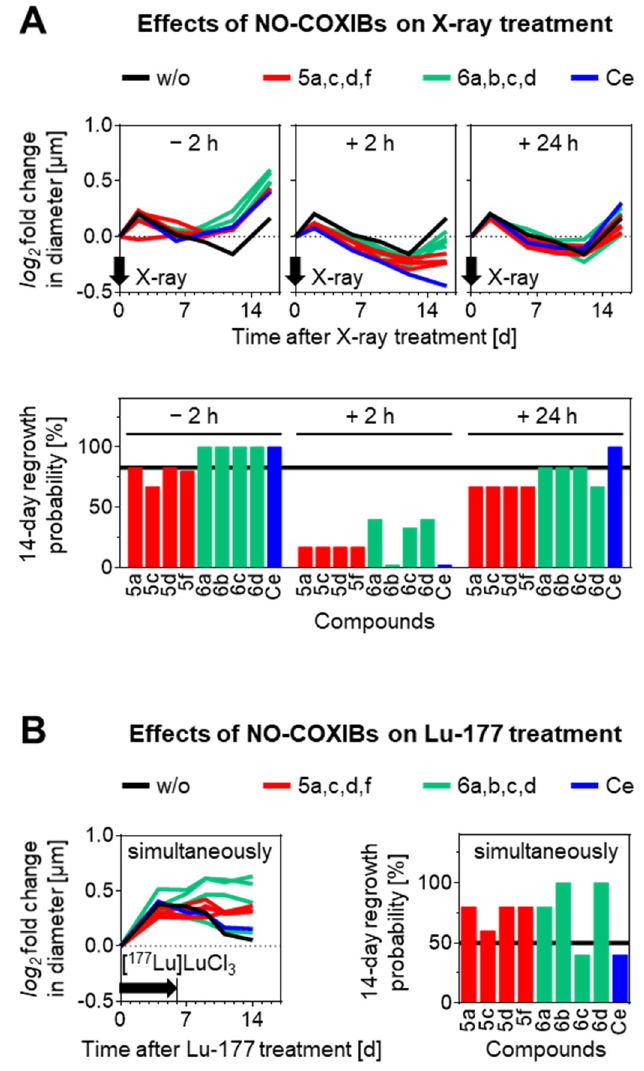
Figure 5. Effects of NO-COXIBs on radiation treatments of MPC-HIF2 α tumor spheroids. ( A ) Growth responses to X-ray treatment with a radiation dose of 15 Gy in combination with 10 µM NO-COXIBs added to the medium at indicated time points before or after irradiation. ( B ) Growth responses to [ 177 Lu]LuCl 3 treatment with an initial activity concentration of 0.25 MBq/mL in combination with NO-COXIBs; log 2 fold changes in diameter indicate the number of diameter doublings compared to treatment start; 14-day regrowth probability indicates the fraction of spheroids able to regrow within 14 days after treatment start; (black arrows) time point or duration of radiation treatment; (w/o) vehicle controls are shown as black lines; (Ce) celecoxib. Altogether, the NO-COXIBs introduced in this study showed the same tendency as celecoxib, exerting both radioprotective and radiosensitizing effects on MPC-HIF2 α sphe- roids when applied shortly before or after irradiation. However, the effects of NO-COXIBs did not exceed those of celecoxib in terms of radiosensitization. This contrasts the bifunc- tional effect of 5a (referred to as compound 5 in our previous report[50]) on clonogenic cell survival under normoxia and hypoxia in melanoma cells showing high (A2058) and